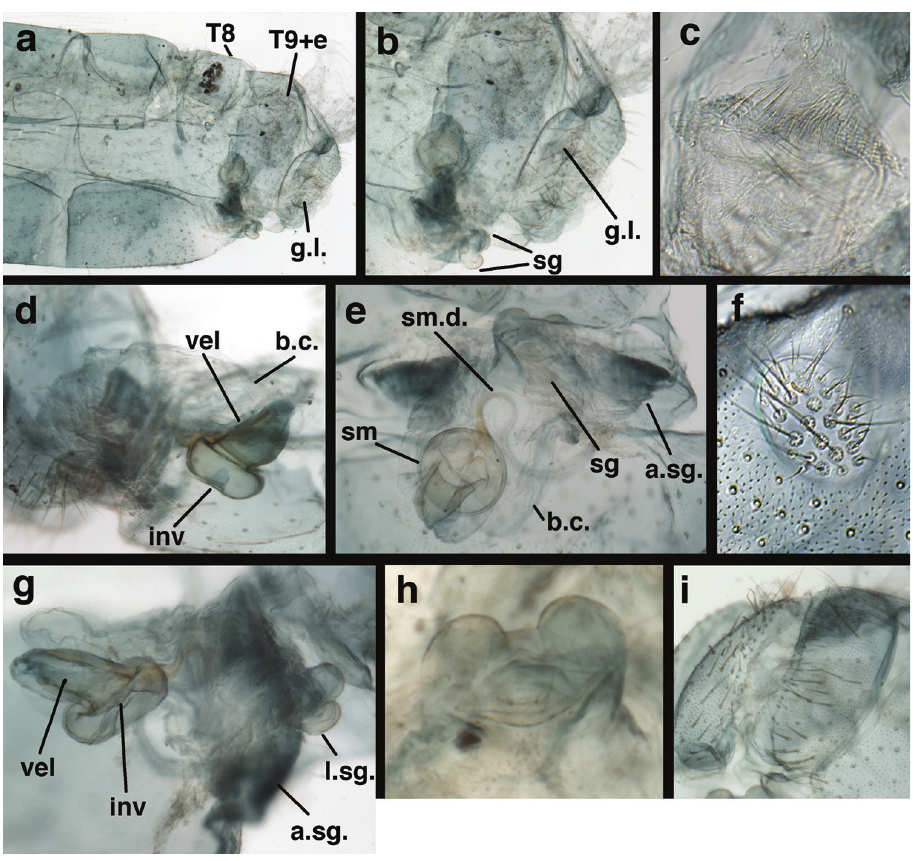
Figure 108. Chrysopa chacranella Banks: Female abdomen and genitalia, ( a ) segments A7-terminus, lat- eral ( b ) terminalia, lateral ( c ) transverse sclerite with ridged striations (internal to gonapophyses laterales) ( d ) spermatheca, lateral ( e ) genitalia, ventral ( f ) callus cerci ( g ) genitalia, dorsolateral ( h ) subgenitale, ventral ( i ) gonaphophyses laterales, posteroventral. a.sg. lateral arm of subgenitale b.c. bursa copulatrix cr crumena g.l. gonapophysis lateralis inv spermathecal invagination l.sg. lobe of subgenitale sg sub- genitale sm spermatheca sm.d. spermathecal duct T8 eighth tergite T9+e ninth tergite and